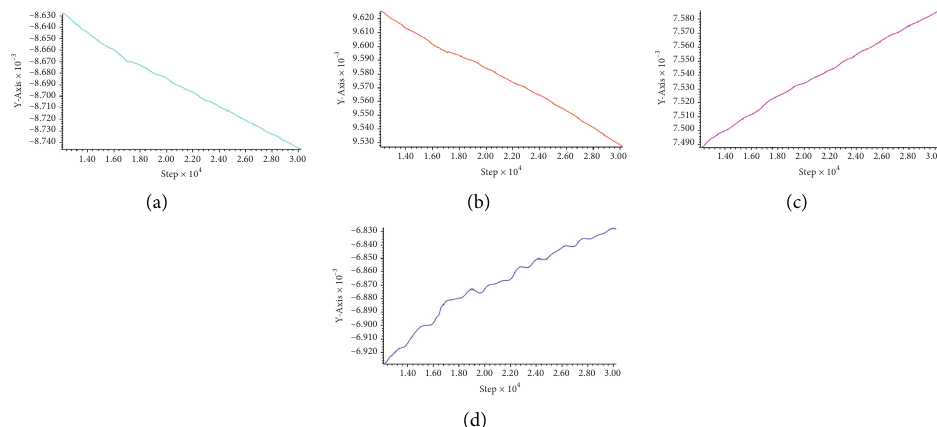
Figure 16: Deformation of surrounding rock when first excavated roadway with bolt support: (a) roof, (b) floor, (c) left side, and (d) right side.